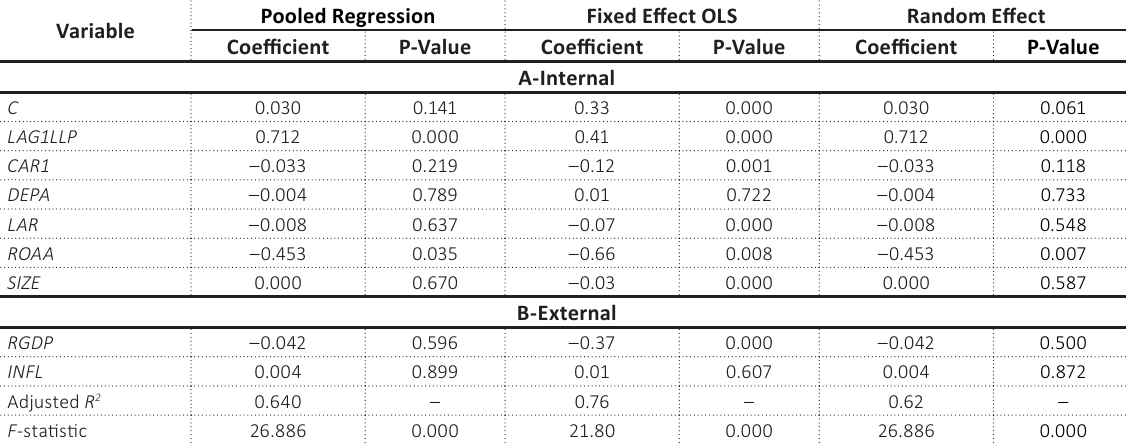
Table 5. Panel regression results of the model